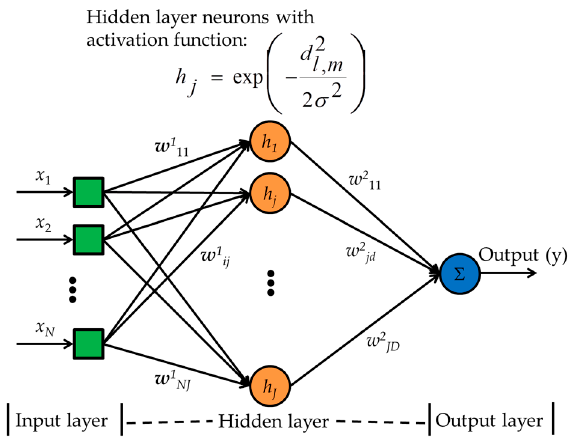
Figure 6. A generalized regression neural network block diagram. d 2 l , m is Euclidean distance and σ is the spreading